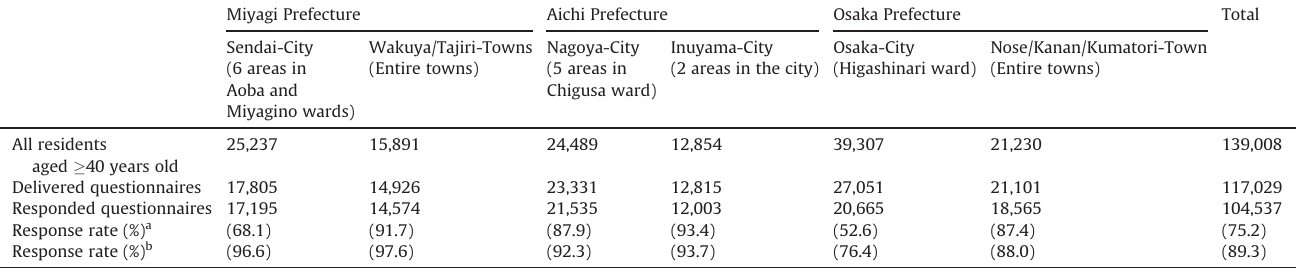
Table 1 Participants of the Three-Prefecture Cohort study.